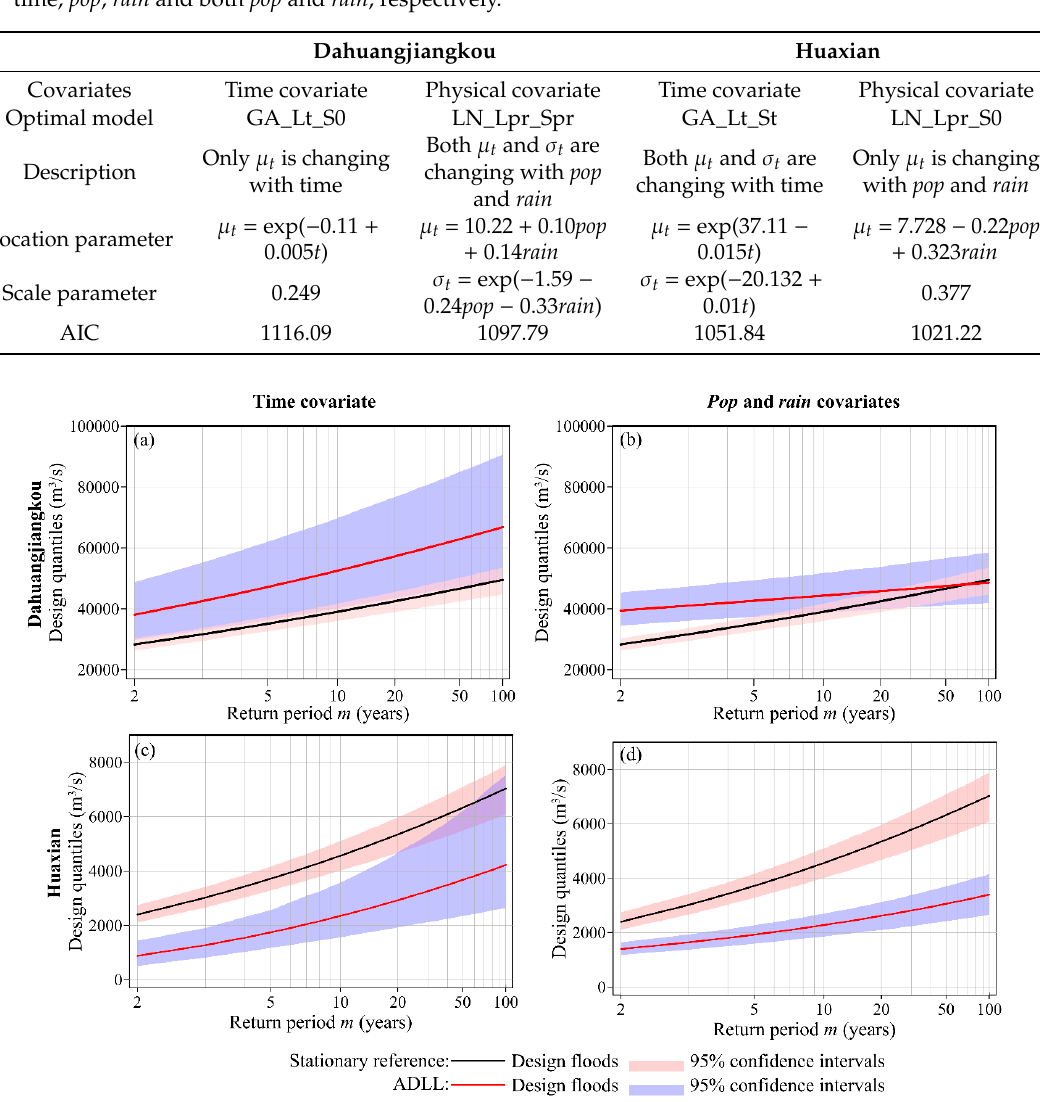
Table 3. Summary of the optimal nonstationary models with time and physically-based covariates. μ and σ are the time-varying location parameter and scale parameter, respectively. Note that letter “L” in the models’ names represents location parameter and “S” represents scale parameters. Number “0” denotes the parameter is invariant, while “t”, “p”, “r” and “pr” denote that the parameter varies with time, pop , rain and both pop and rain , respectively.